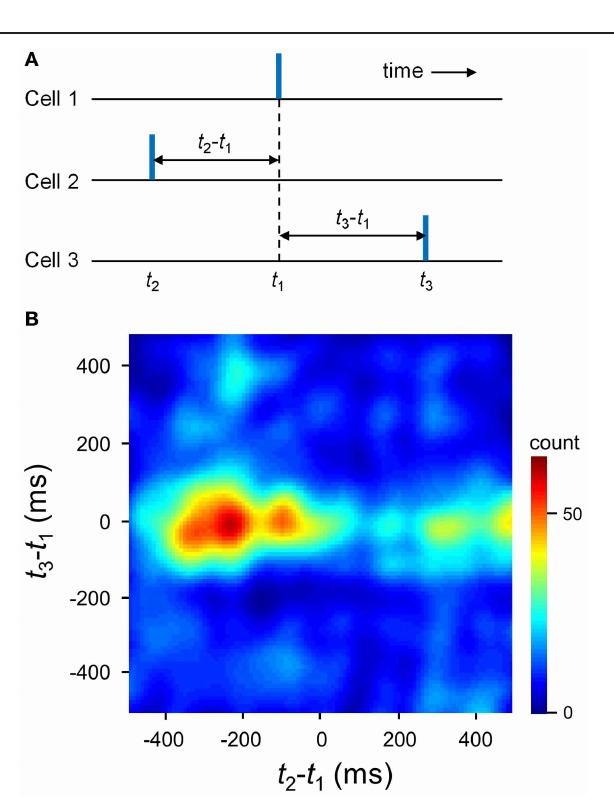
FIGURE 8 | Pairwise correlogram of precisely repeating triplets. (A) For every trio of neurons, a spike triplet is described by two inter-spike intervals ( t 2 – t 1 and t 3 – t 1 ). (B) Count matrix for a representative triplet of neurons, indicating the probability of different inter-spike interval combinations.